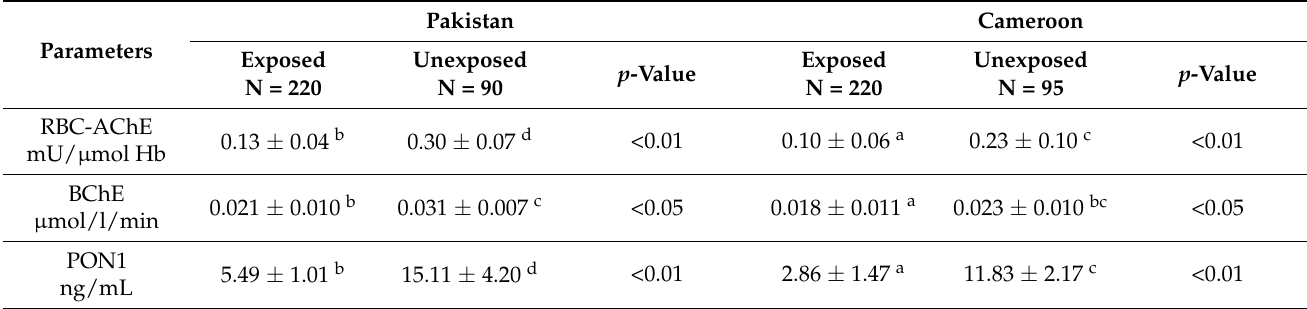
Table 2. Variation of Cholinergic/PON1 enzymes of OPPs exposed and nonexposed groups in two populations.